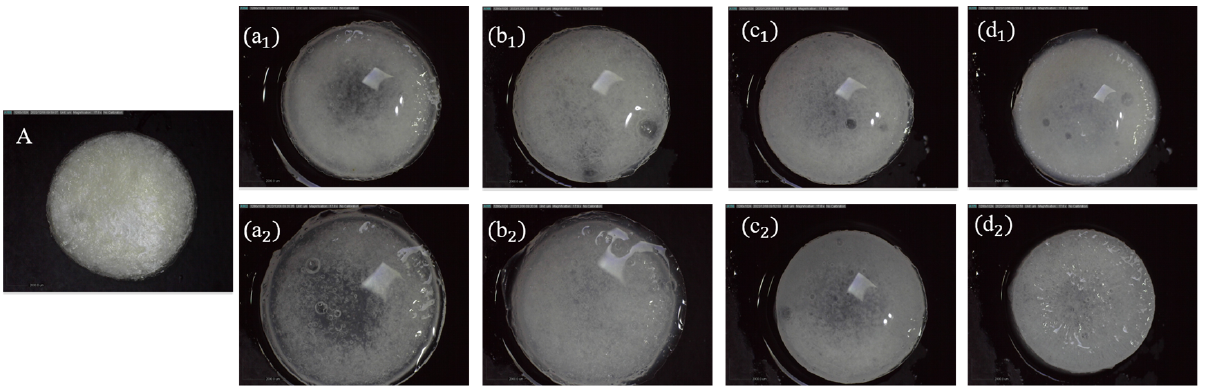
Figure 3. Swelling of hydrogels crosslinked with CaCl 2 at different concentrations. ( A ) Unswollen hydrogel. Swollen hydrogels crosslinked with calcium at CaCl 2 concentrations of 1%, 2%, 5%, and 10% for pH 1.2 ( a 1 – d 1 ) and pH 7.4 ( a 2 – d 2 ).